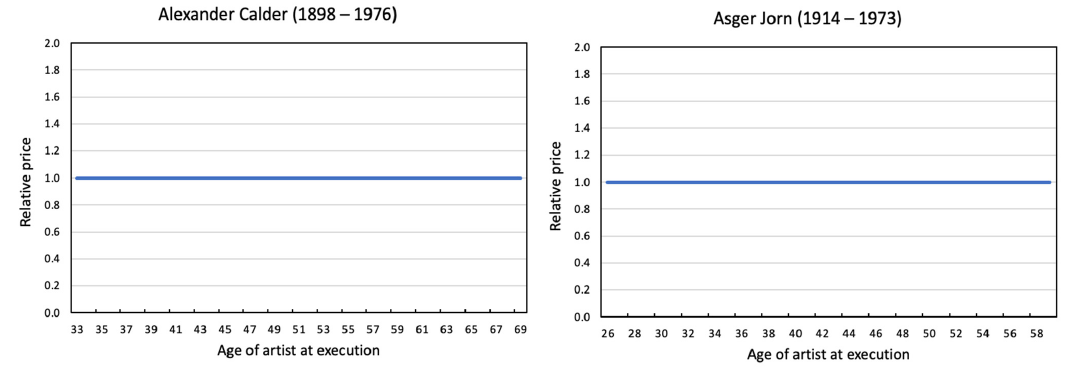
Figure 2. Relative prices for paintings executed at different ages by Alexander Calder and Asger Jorn. Six of the artists died during the period of auction sales included in my analysis. Their age profiles are given in Figure 3, which shows that collectors of Joan Mitchell and Cy Twombly were indifferent between paintings executed at different stages of their careers.